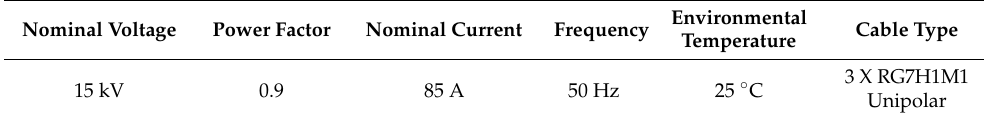
Table 1. Main characteristics of the MV underground line.